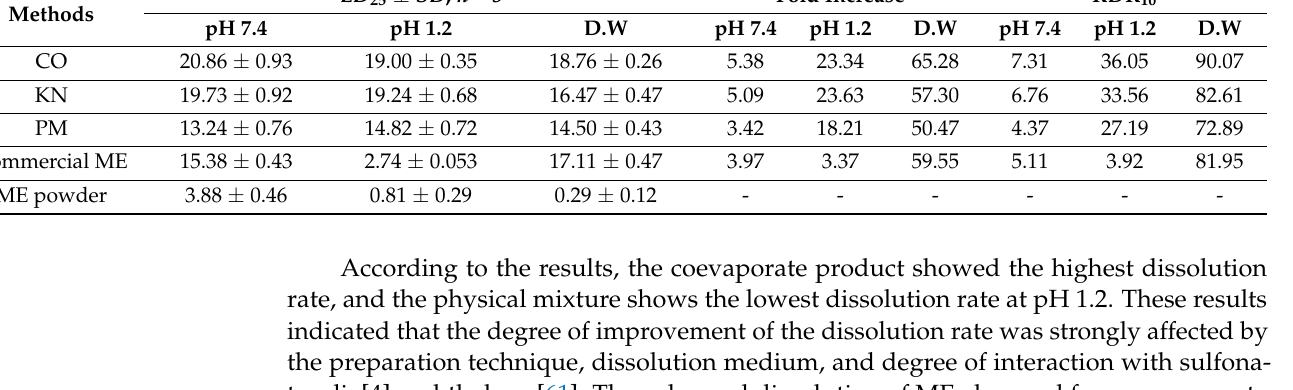
Table 2. Dissolution Efficiency (ED 25 ) and Relative Rate of Dissolution (RDR 10 ) in different media for the coevaporation (CO), kneaded (KN), physical mixture (PM), commercial meloxicam, and meloxicam untreated powders. ( n = 3, ± S.D.). Methods